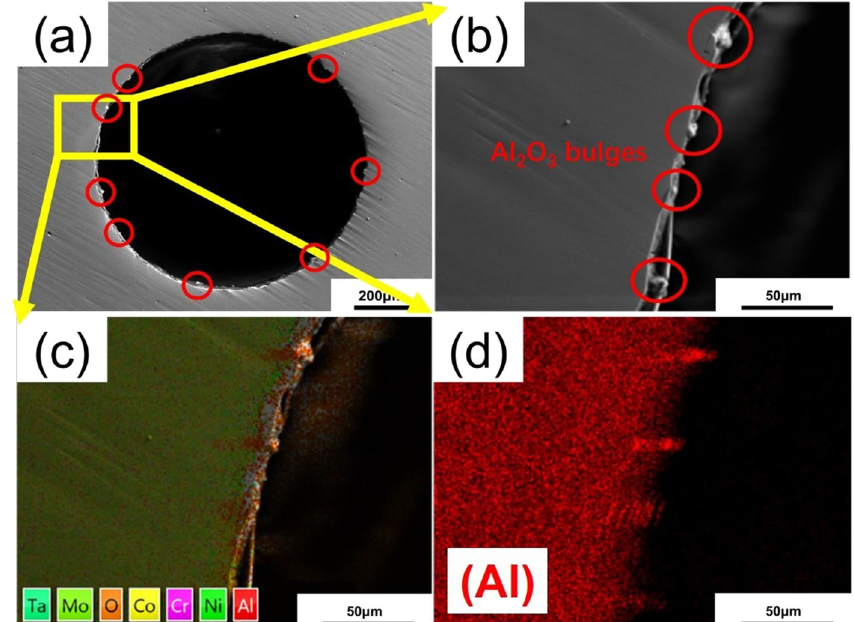
Fig. 3 The original structures around the hole of the alloy specimens after drilling. a The overall microstructure; b – d local microstructure.